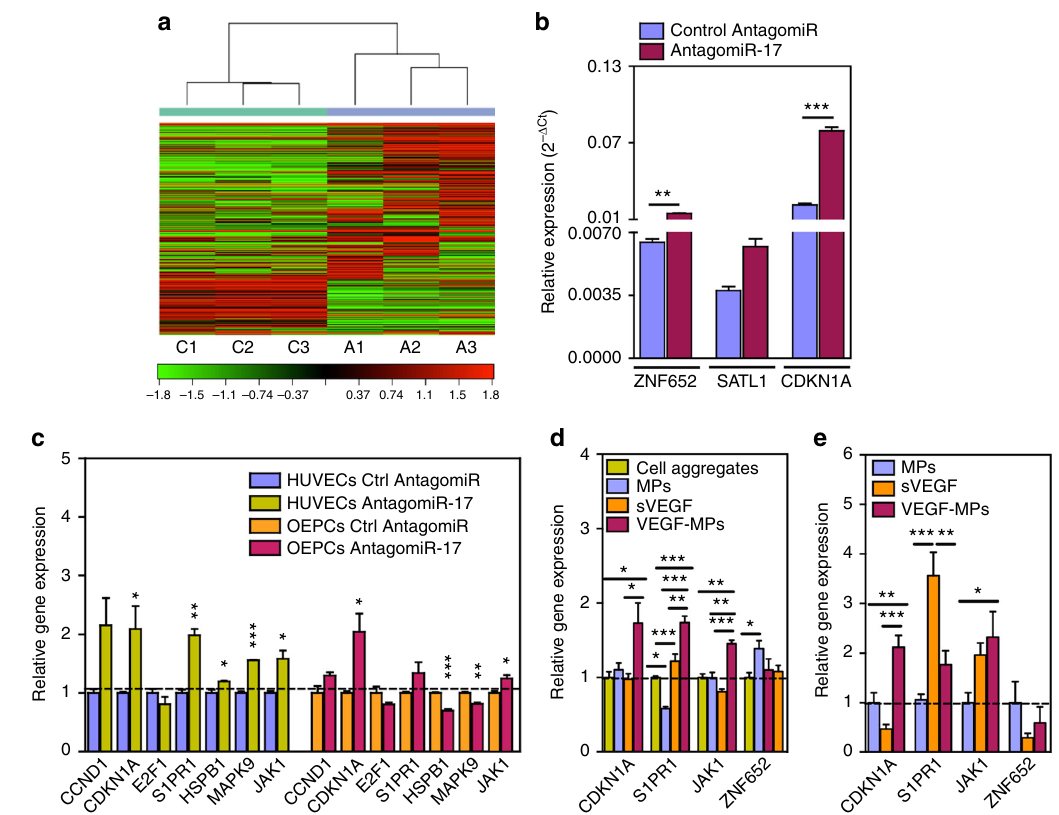
Fig. 6 Gene targets of miR-17 in OEPCs. a , b mRNA sequencing was performed for OEPCs transfected with control antagomiR or antagomiR-17 for 48 h. a The heat map diagram showing the result of the two-way hierarchical clustering of RNA transcripts and samples, by including the top 500 transcripts (genes) that have the largest log2 fold difference based on FPKM counts. Each row represents one RNA transcript and each column represents one sample. The color of each point represents the relative expression level of a transcript across all samples. The color scale is shown at the bottom : red represents an expression level above the mean; green represents an expression level below the mean. On heat map, C is control amiR while A is amiR-17 . b Validation of three gene targets by qRT-PCR. c The expression of previously reported miR-17 gene targets in HUVECs and OEPCs transfected with amiR-17 . The results were normalized to control amiR group for each gene. Among the genes tested, CDKN1A was signi fi cantly upregulated in both of the cell types transfected with amiR-17 . The upregulation in the expression of CDKN1A was also con fi rmed in OEPC aggregates containing conjugated VEGF in both 24 h in vitro ( d ) and 24 h in vivo ( e ) samples. The gene expression results were normalized to cell control group (cell aggregates). Results are average ± SEM ( n = 4 – 8). In b and c , unpaired t- test was performed between ctrl amiR and amir-17 groups, while one-way ANOVA followed by a Bonferroni post test was used among groups in d and e for statistical analysis. * P ≤ 0.05, ** P ≤ 0.01, and *** P ≤